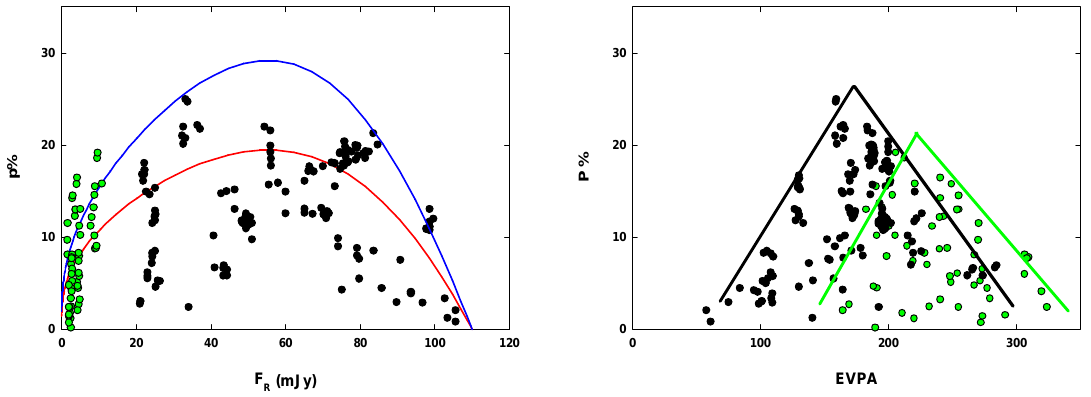
Figure 5. Left: Dependence of CTA 102 optical polarization on R -band flux density. Green circles correspond to the 2012 outburst and black to the outburst of 2016–2017. Curves correspond to expectations of a model that explains most flux and polarization variations with changing viewing angle. The red curve corresponds to a plasma compression ratio of η = 1.3. The blue curve has η = 1.5. Right: Dependence of optical polarization on EVPA for 2012 (green) and 2016–2017